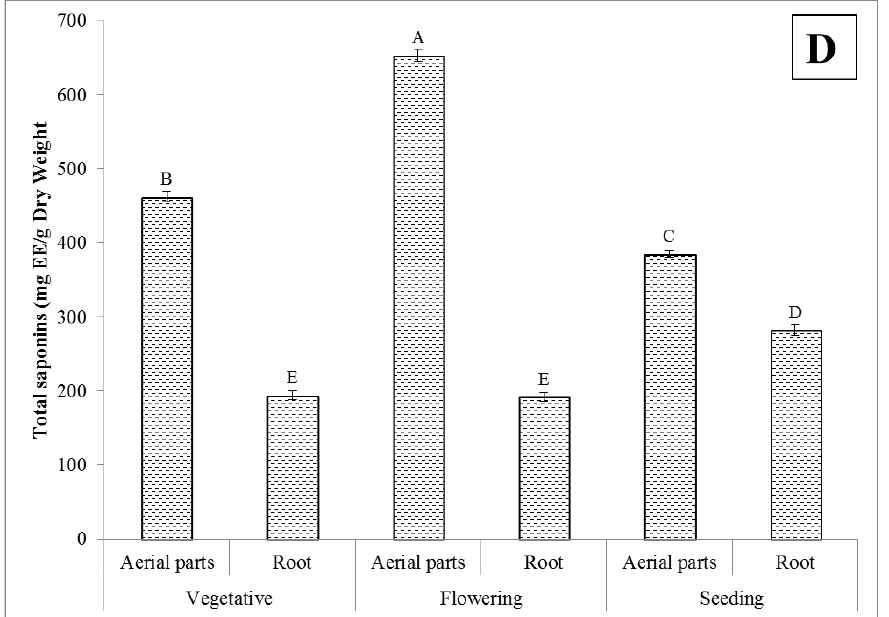
Figure 1. The total contents ( n = 3) of ( A ) phenolics, ( B ) flavonoids, ( C ) alkaloids, and ( D ) saponins in the extracts of the T. polium aerial parts and root at different phenological stages of this plant. The extract concentration is 1 mg/mL. Various letters indicate statistically significant differences ( p < 0.05).